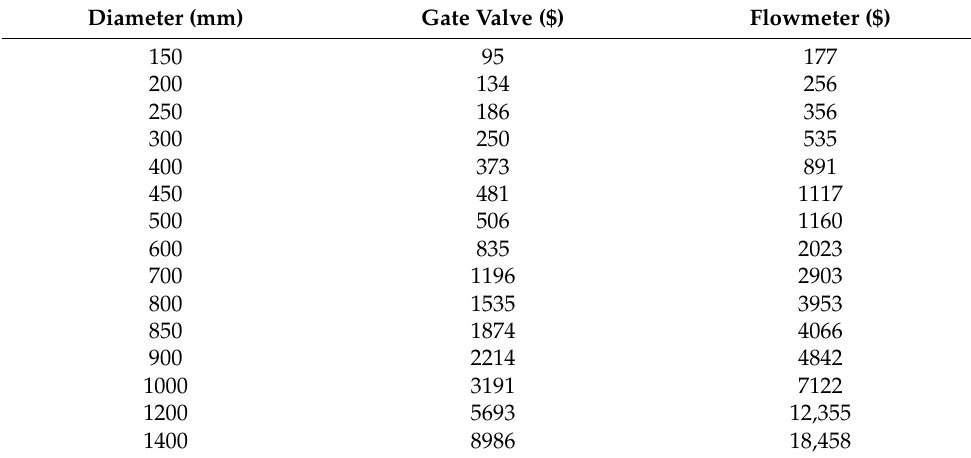
Table 1. The price of the flowmeter and gate